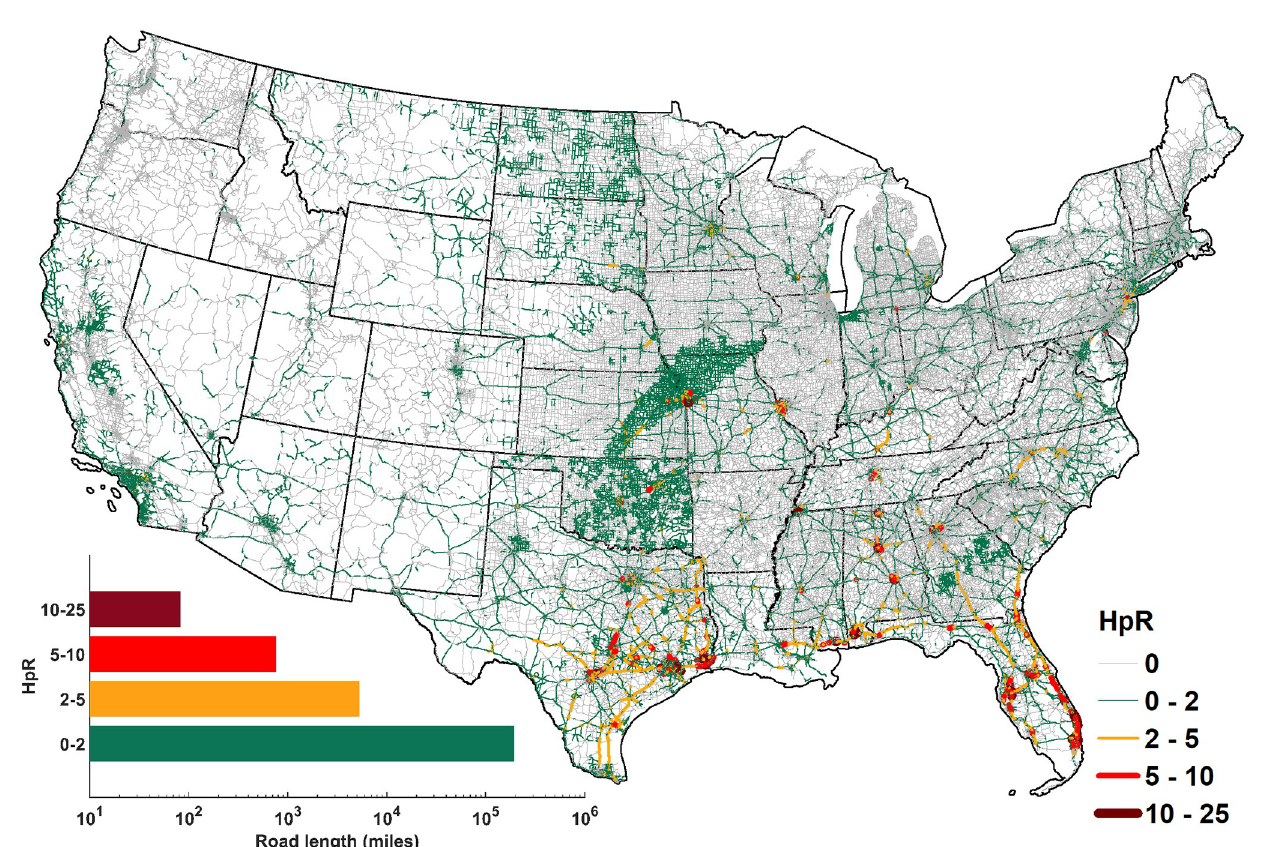
Fig 1. Hydroplaning risk (HpR), quantified as average annual frequency of high risk events (HREs), for road sections within the continental US